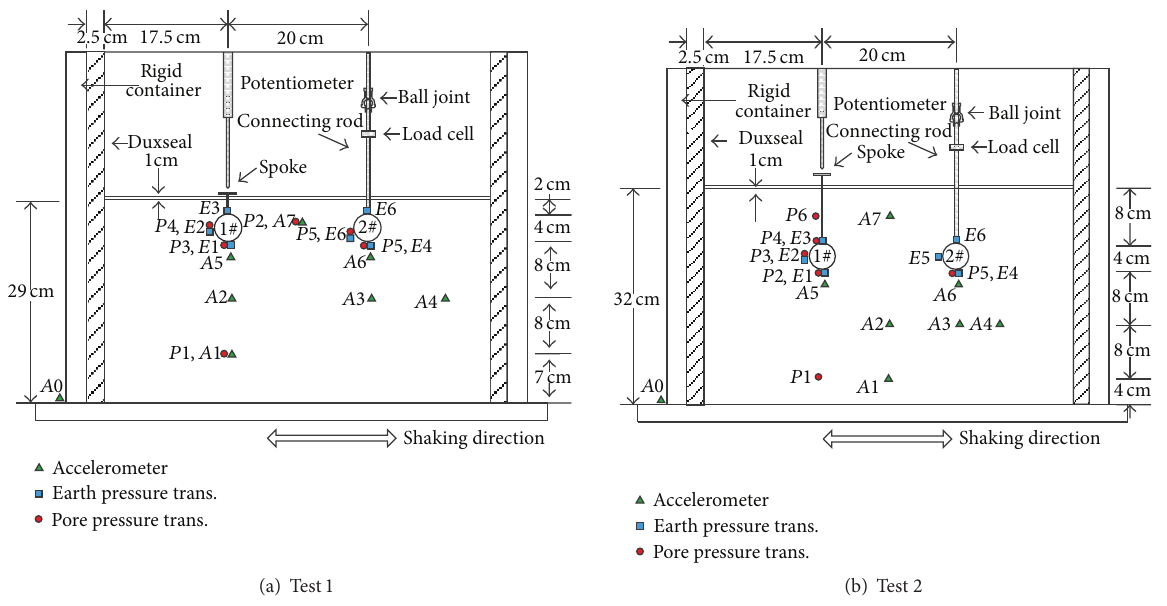
Figure 2: The layout of pipes and